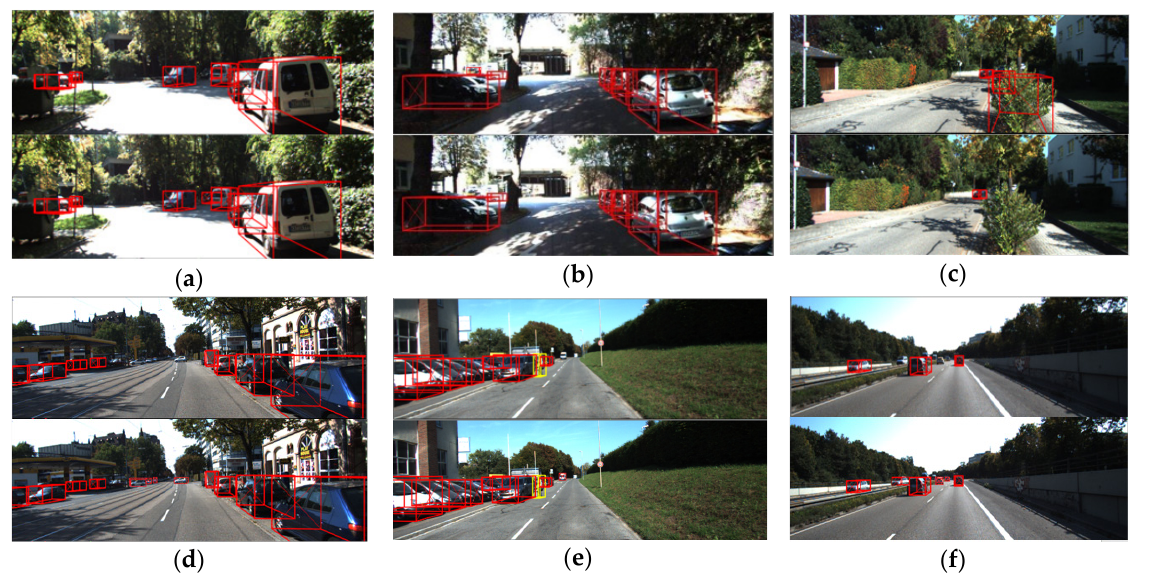
Figure 11. Comparison of detection results before and after the improvement of the AVOD fusion algorithm. ( a – c ) are the detection results before the improvement and ( d – f ) are the results of the improved algorithm.